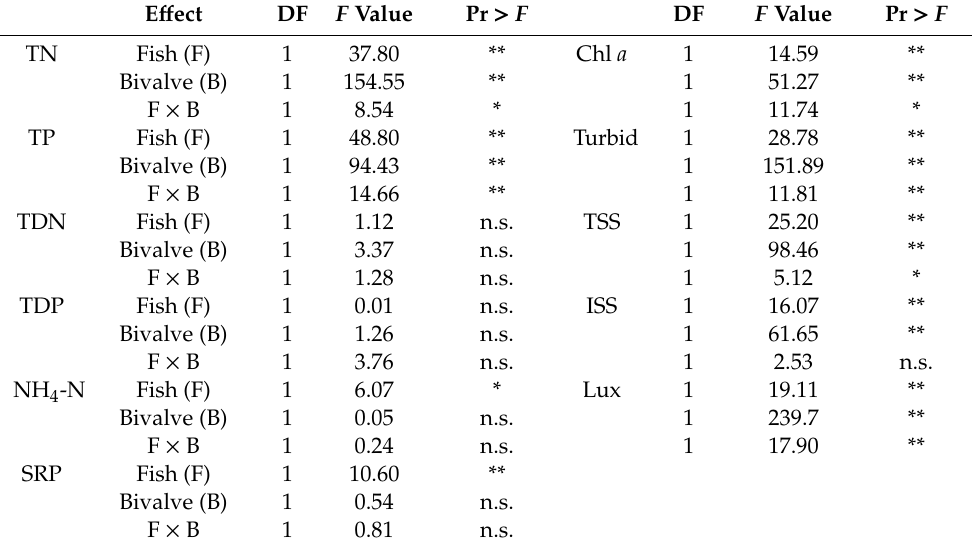
Table 1. Results of repeated measures analysis of variance (rANOVA) for water chemical parameters, water clarity and light intensity based on time-weighted data recorded during the experiment. E ff ect DF F